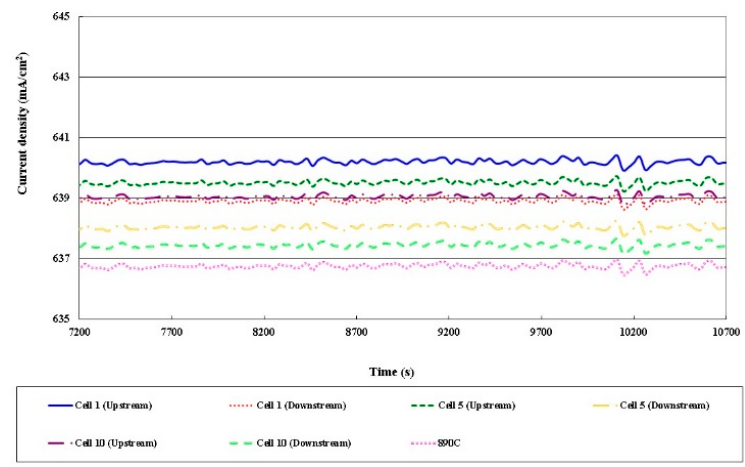
Figure 16. Comparison of local current densities in different cells (part of 20A).